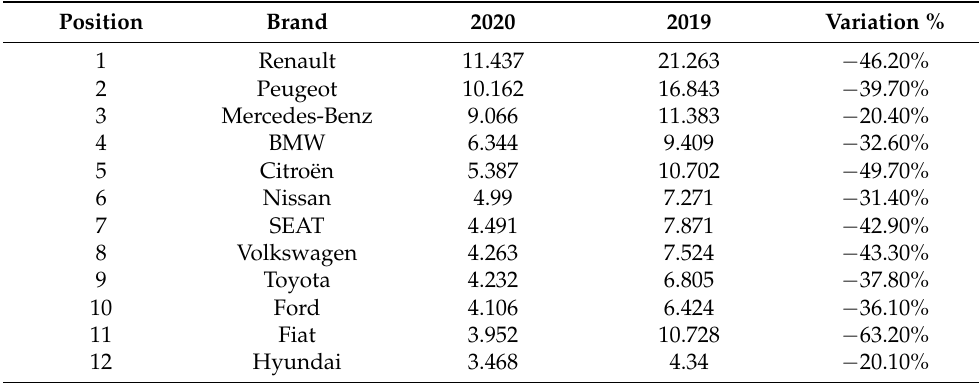
Table 5. The twelve most registered brands in Portugal, first 8 months of 2020